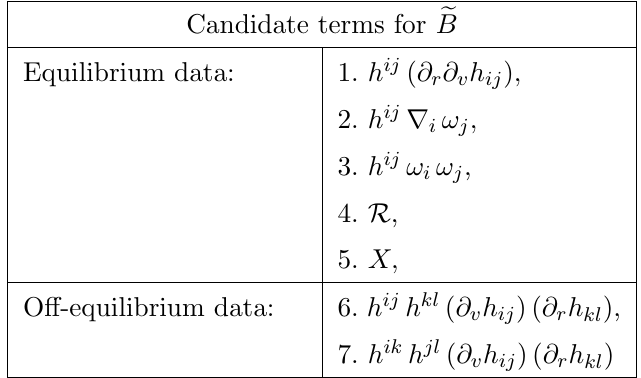
Table 9 . Possible structures that can appear in e B : each of them has two derivatives and boost weight=